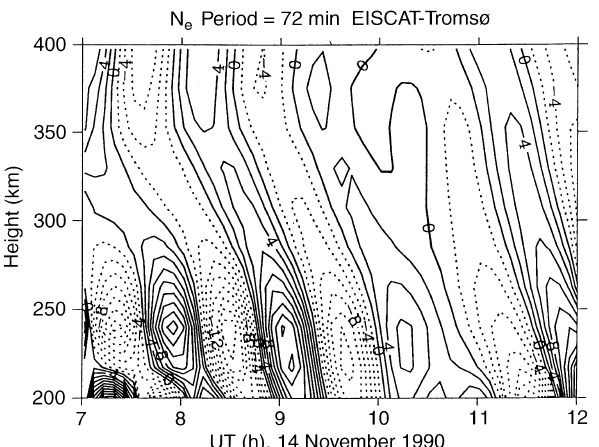
Fig. 4. Electron density fluctuations within a period band of 60–90min as a function of time and height for the same TID event as shown in Fig. 3